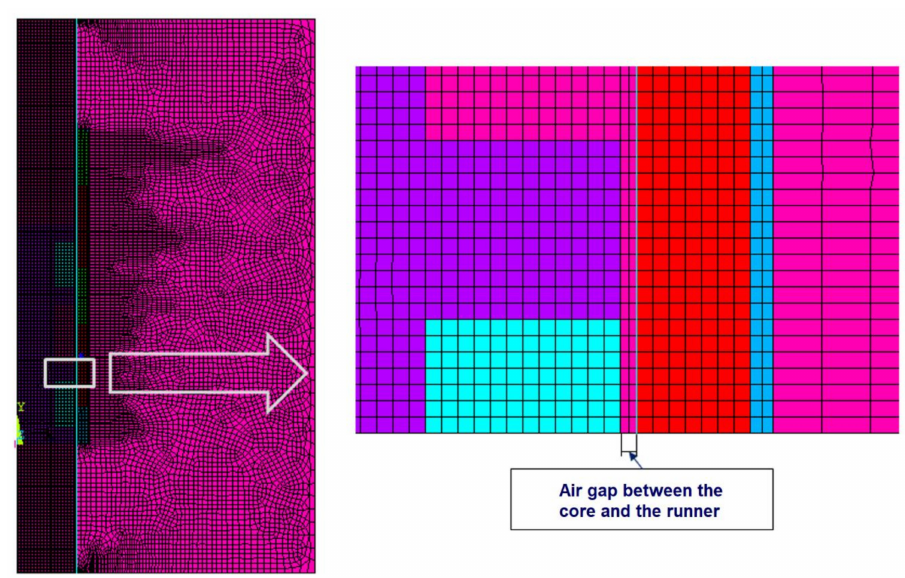
Figure 10. Field model divided into finite elements.